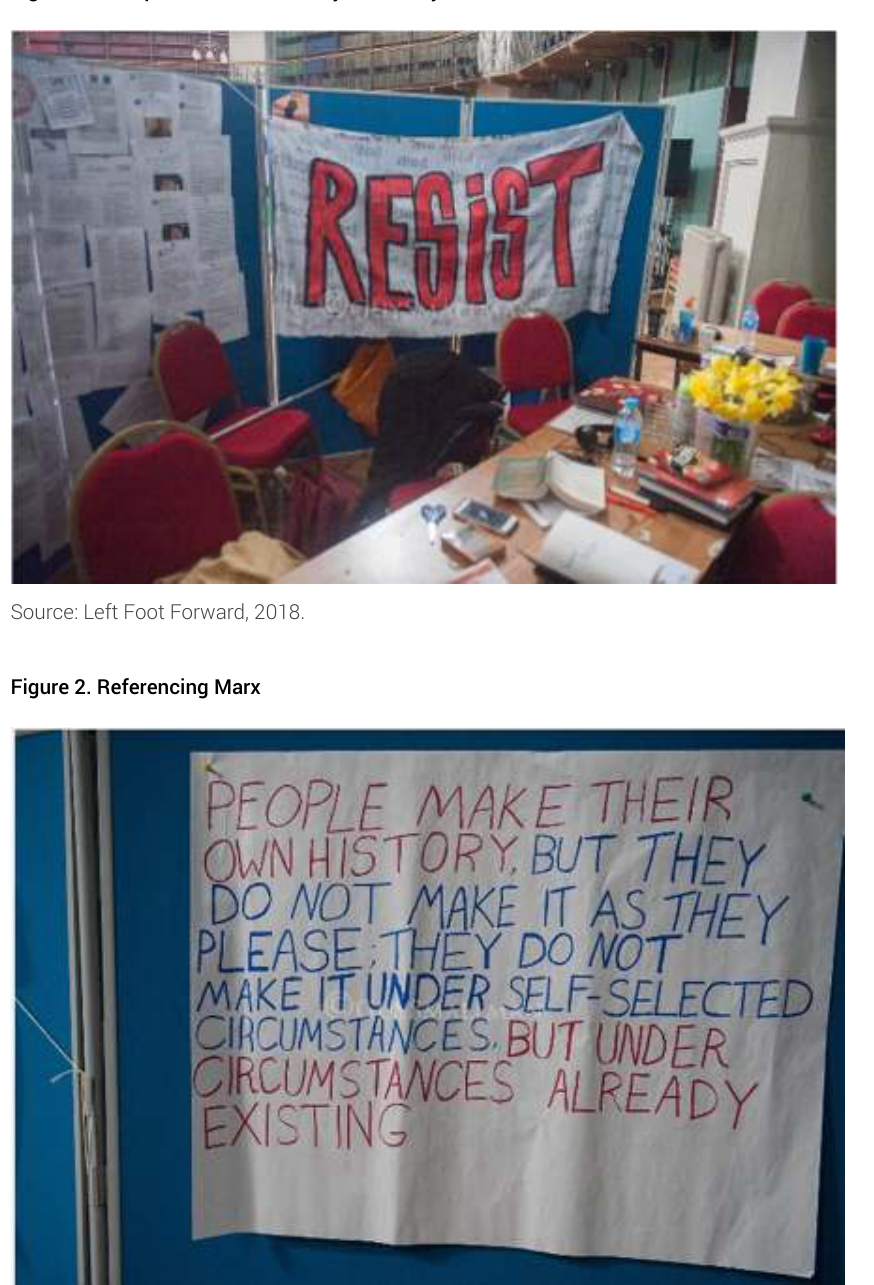
Source: Left Foot Forward,